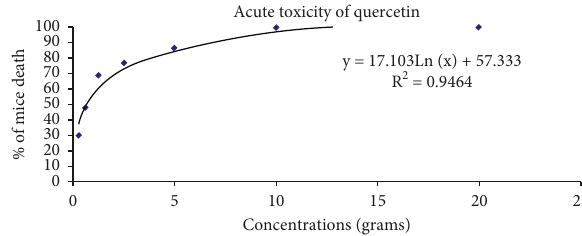
Figure 2: The dose-response curve of the quercetin complex against five groups of randomly distributed